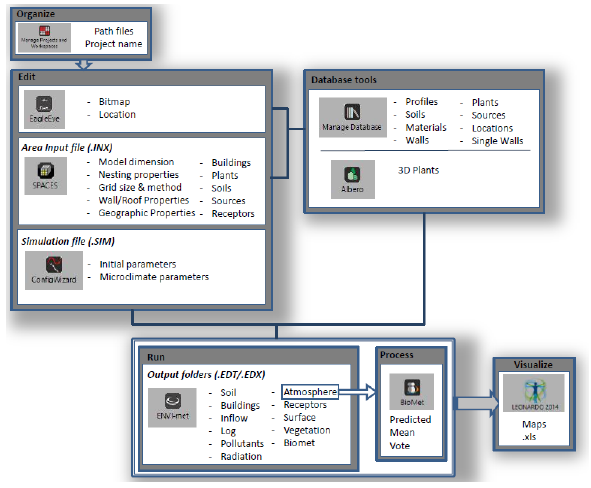
Figure 2: ENVI-met